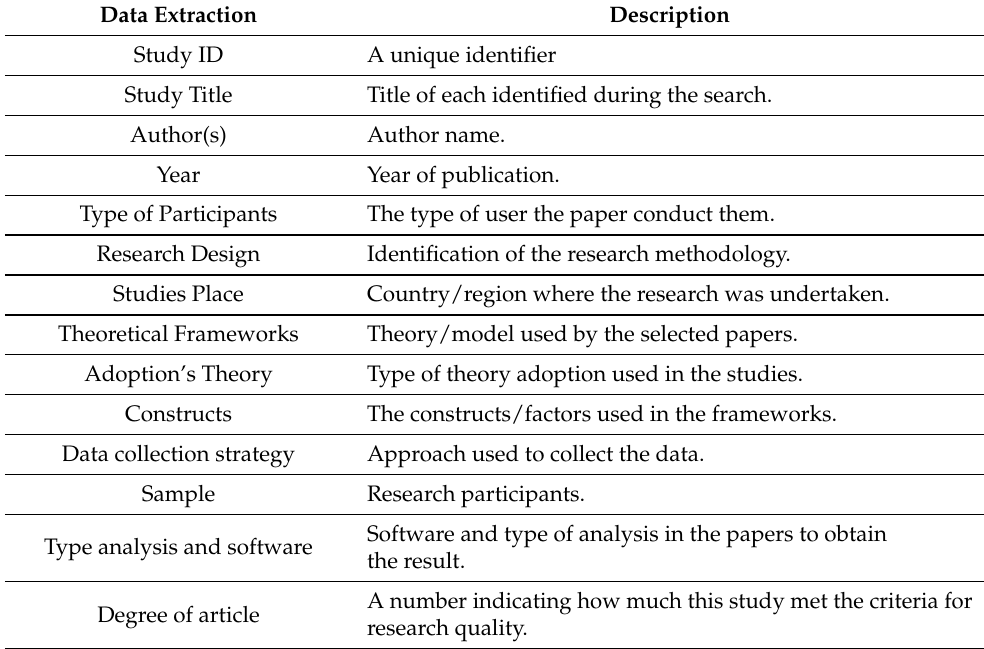
Table 2. Elements of the data extraction form with